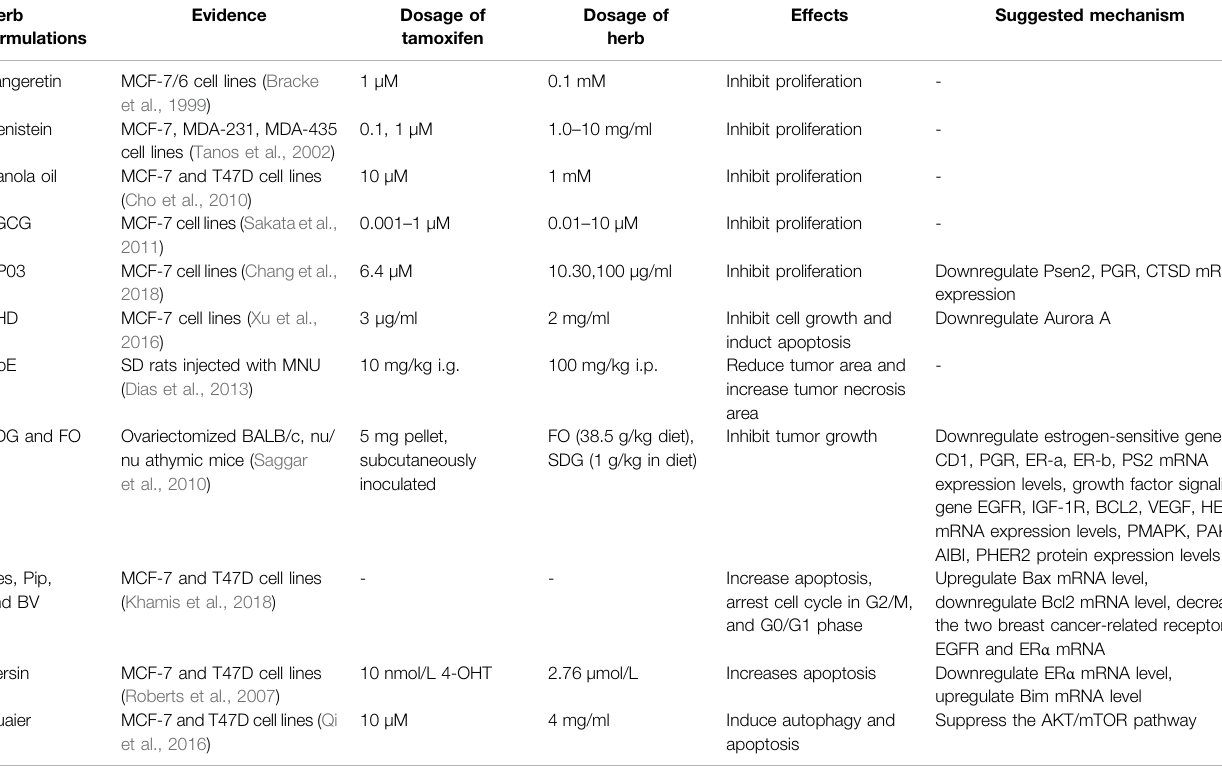
TABLE 3 | Reported synergetic effects of inhibiting proliferation or inhibiting tumor growth Herb formulations